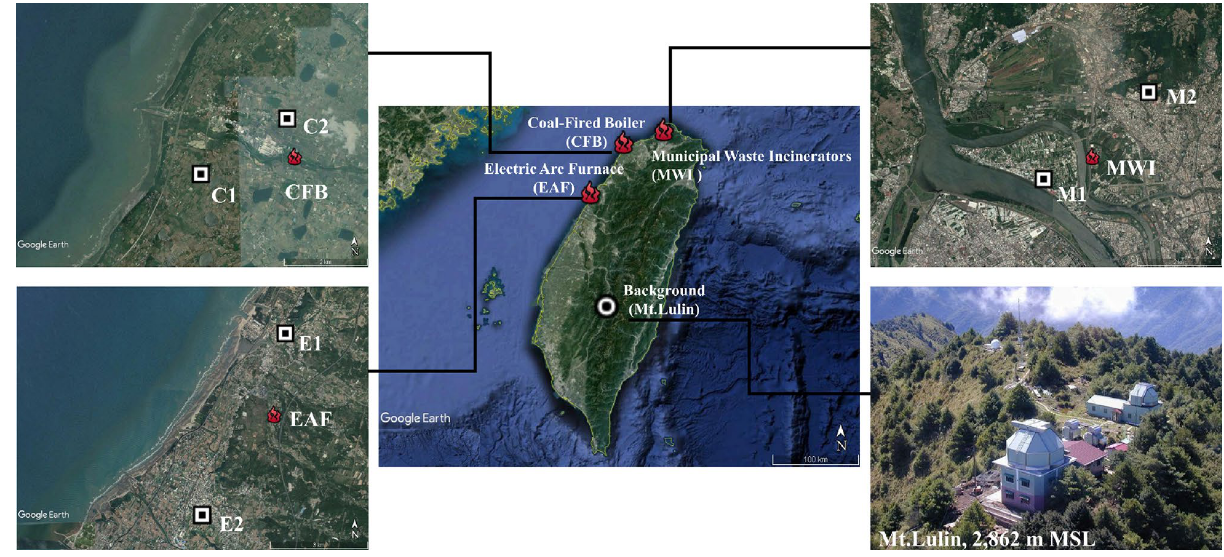
Figure 4. Locations of stationary source and atmospheric PCDD/Fs sampling sites in Taiwan. This map and the picture of Mt.Lulin were provided by the Google earth pro version 7.3.3. and Lulin Observatory (http:// www. lulin. ncu. edu. tw/ engli sh/), National Central University,